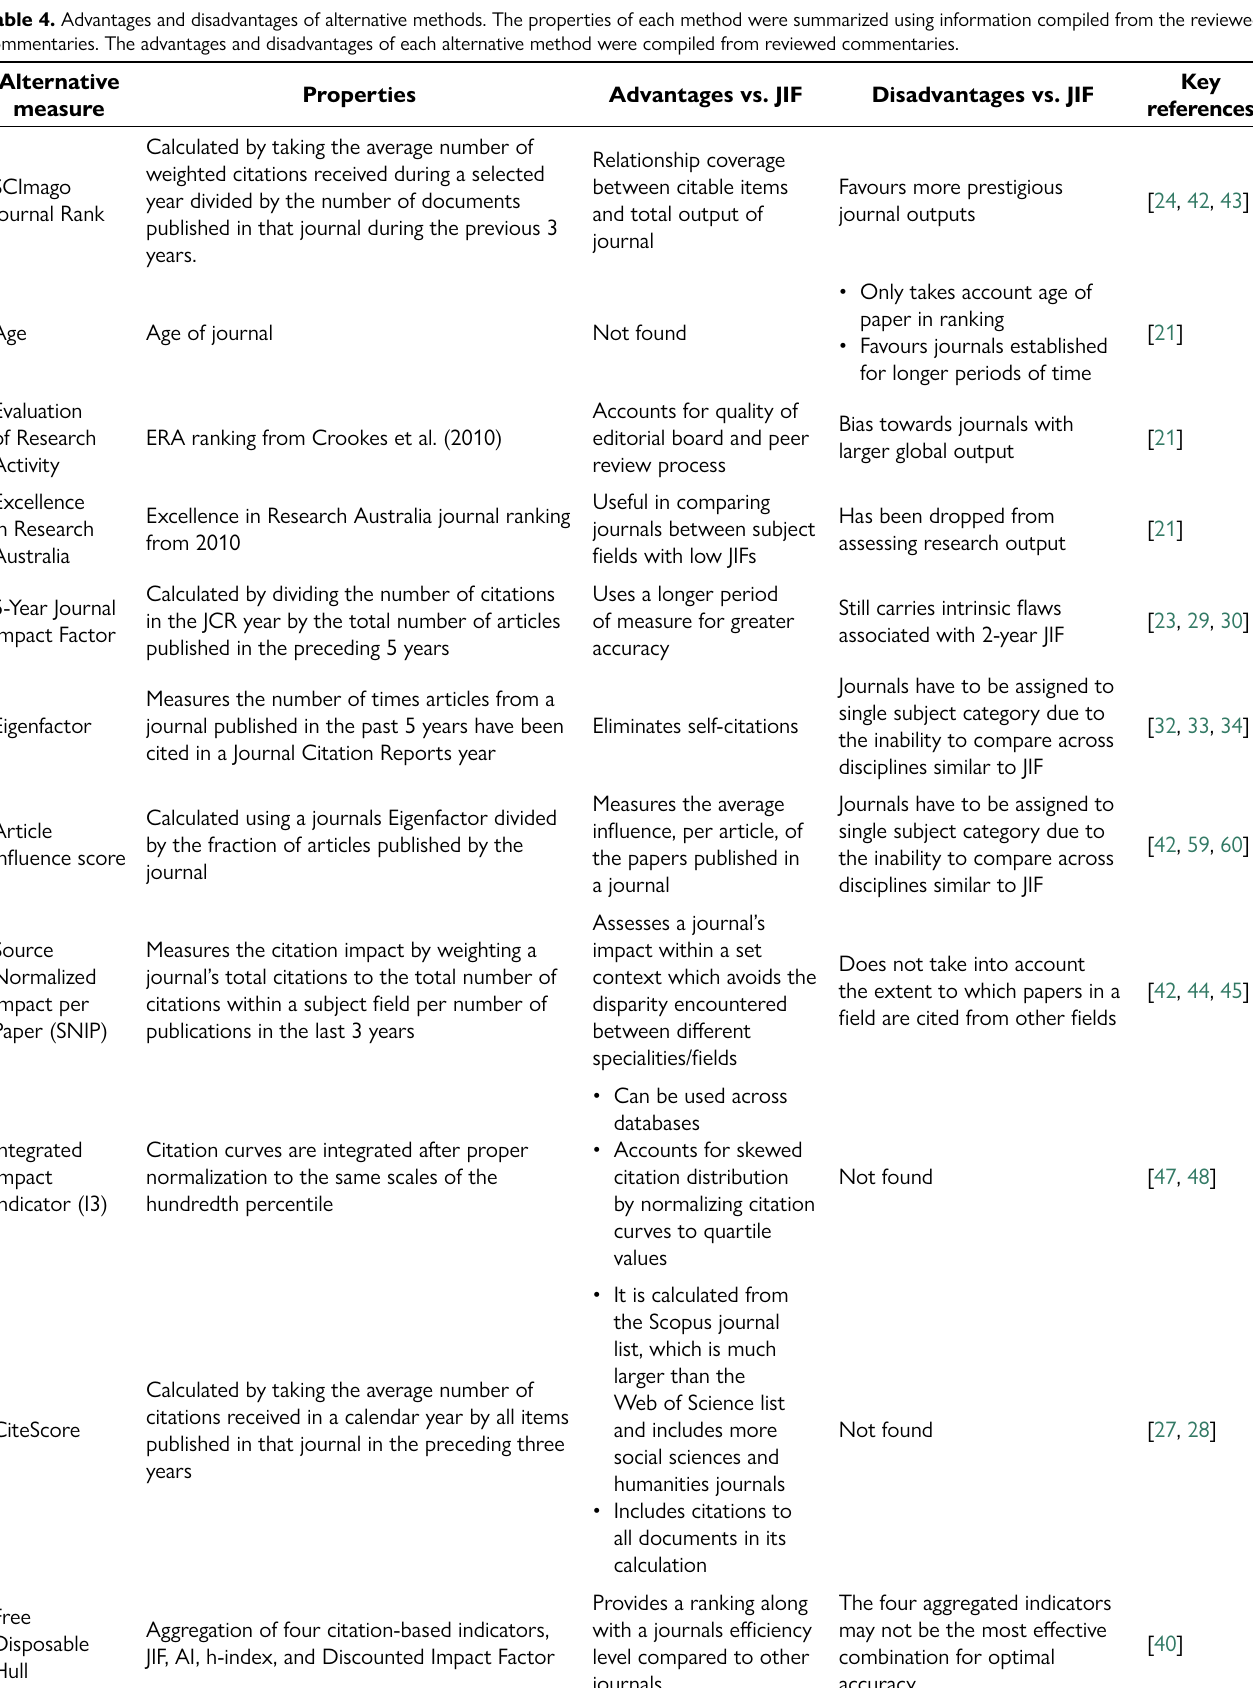
Table 4. Advantages and disadvantages of alternative methods. The properties of each method were summarized using information compiled from the reviewed commentaries. The advantages and disadvantages of each alternative method were compiled from reviewed